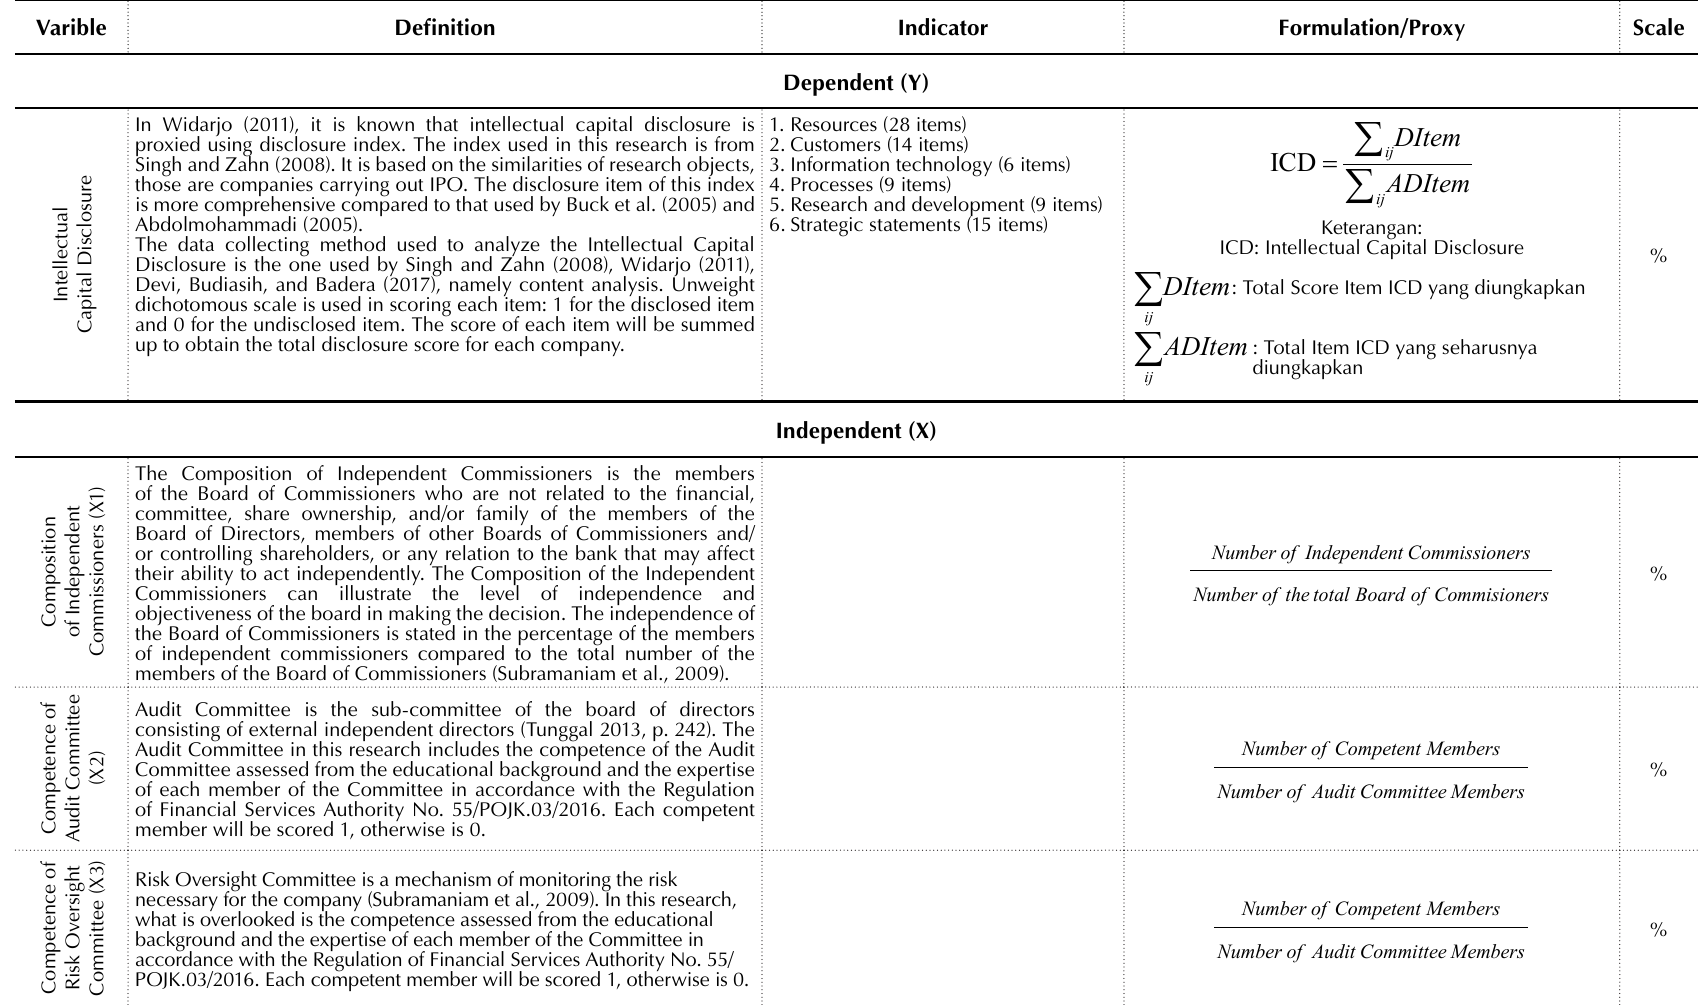
Table 1. Operational definition Varible Definition Indicator Formulation/Proxy